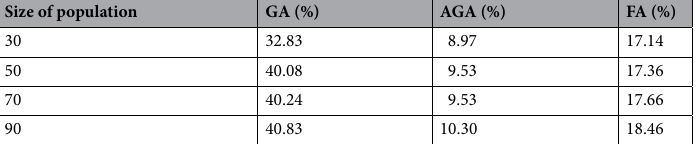
Table 2. Compared with the other 3 algorithms, the percentage of improvement in PID parameter evaluation value is optimized by PAAFA for different population sizes.